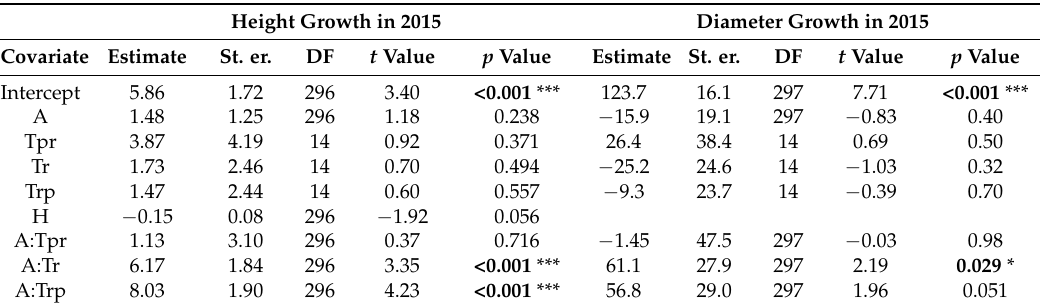
Table 4. Model statistics for the linear mixed models of the continuous response variables height and diameter growth in the second growing year.